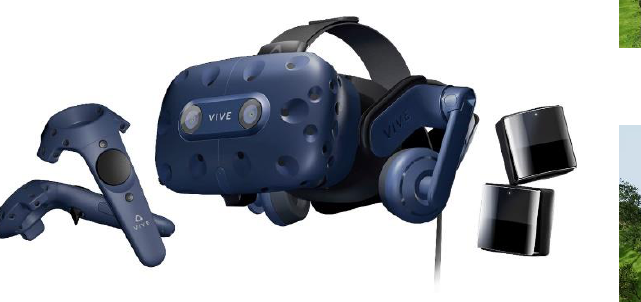
Figure 1. HTC Vive Pro with controllers and lighthouses